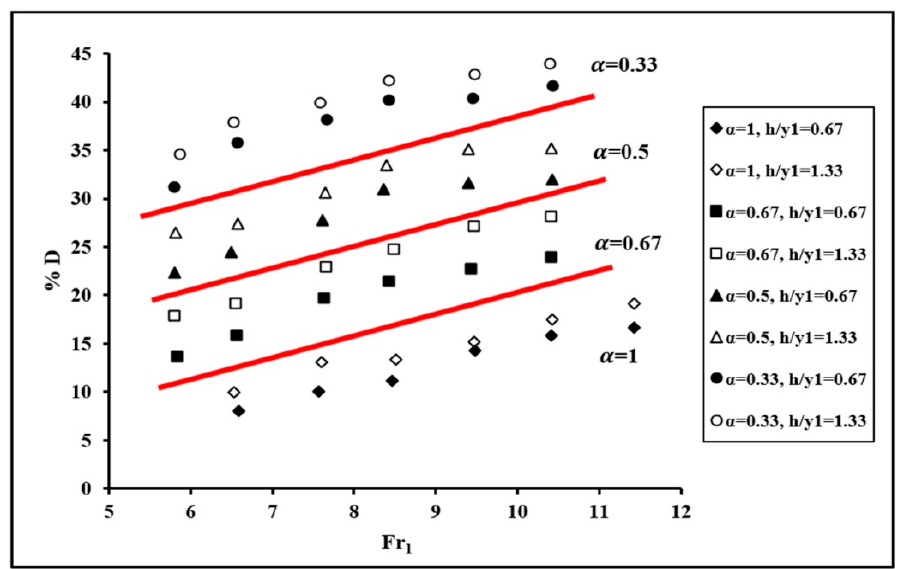
Figure 9. Non-Dimensional depth deficit D , versus Fr 1 .